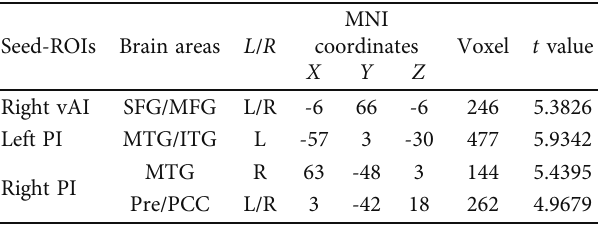
Table 2: Brain areas showing functional connectivity di ff erences with insular subregions between pre-CPAP and post-CPAP OSA. Seed-ROIs Brain areas L /